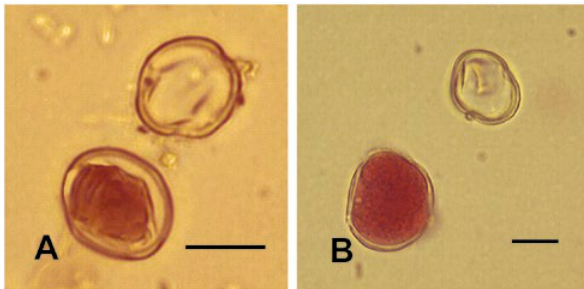
Figure 4. A-J: Fertile/stained and Sterile/unstained pollen grains in; A) Buddleja iresinoides and, B) Castilleja arvensis. Scale = 10